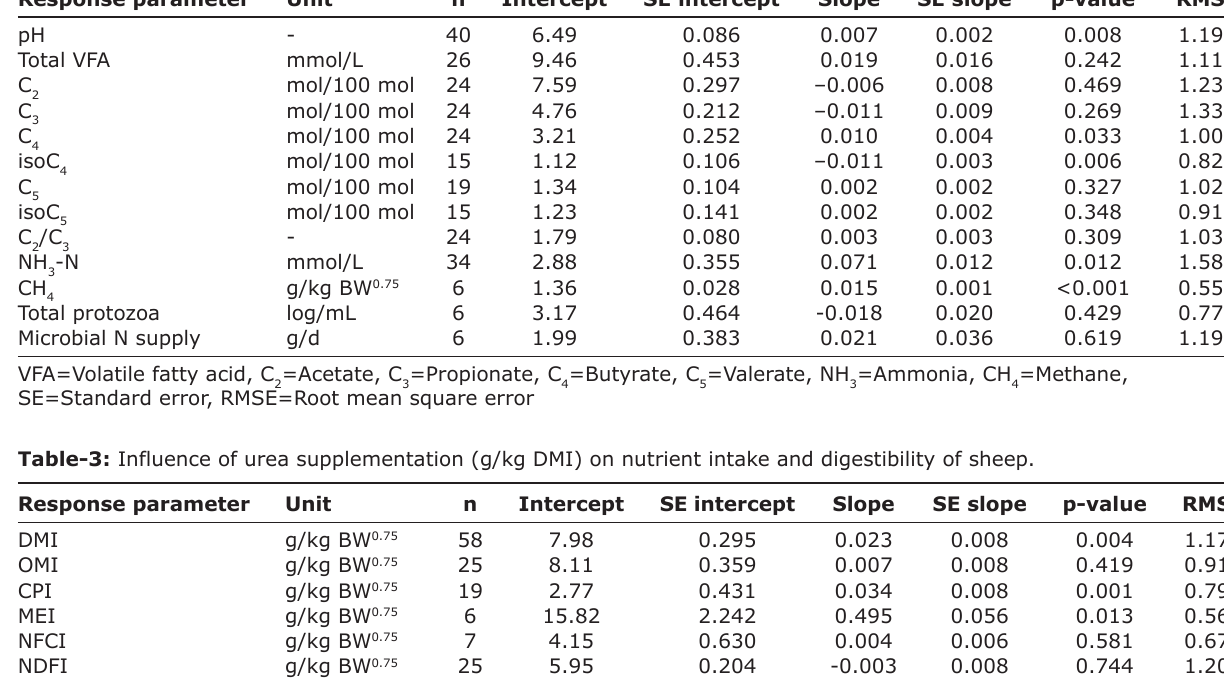
Table-2: Influence of urea supplementation (g/kg dry matter intake) on rumen fermentation of sheep. Response parameter